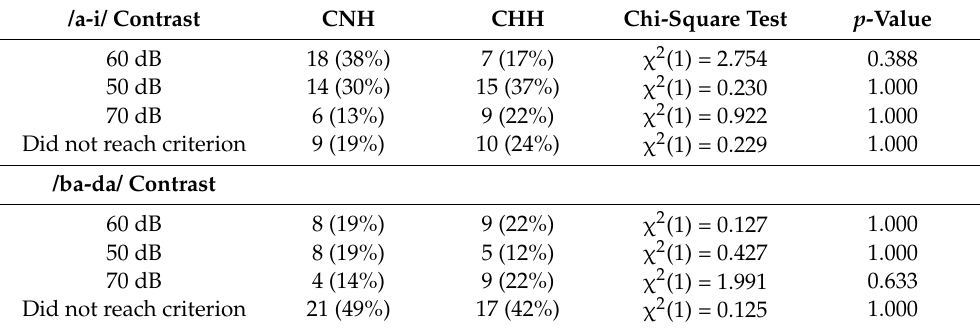
Table 3. Participants who reached criterion in CHT task. p -values include Bonferroni corrections for multiple